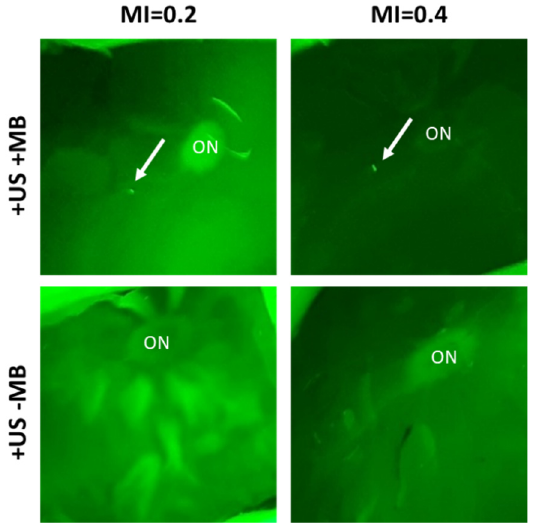
Figure 5. Macroscopic images of retina flat mounts of eyes during excitation with a green fluorescent light. Top: eyes treated with USMB (left: MI 0.2, right: MI 0.4), bottom: eyes exposed to ultrasound but no microbubbles. White arrows indicate the spots where SYTOX TM green-positive cells were present. Retinal detachment is an artefact of flat mount preparation. ON: optic nerve head.